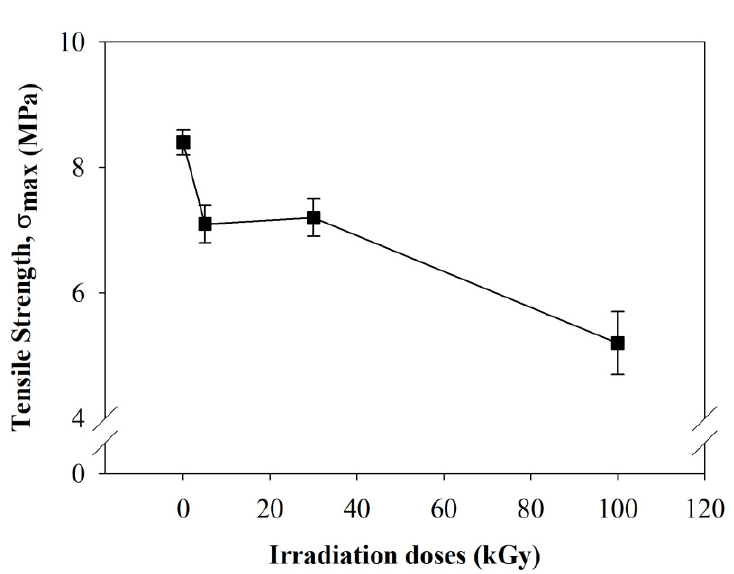
Figure 8. The effect of electron-beam irradiation to the tensile properties of PLLA/CMS/ β -TCP nanofibers.